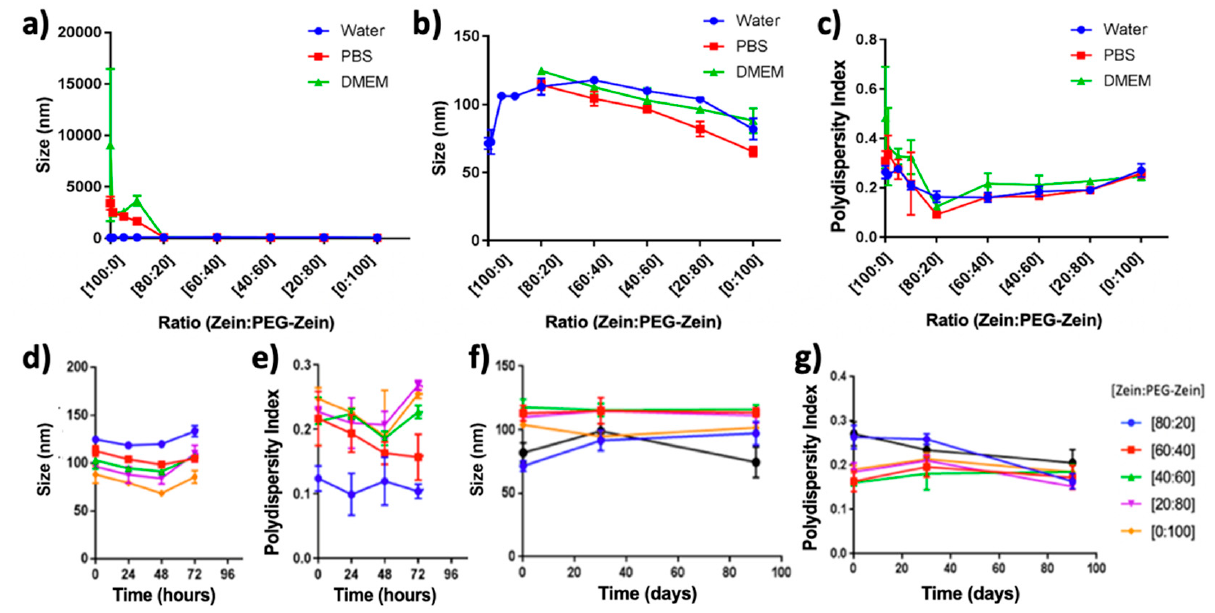
Figure 7. ( a ) Size as determined by dynamic light scattering (DLS) of [100:0], [99:1], [95:5], [90:10],